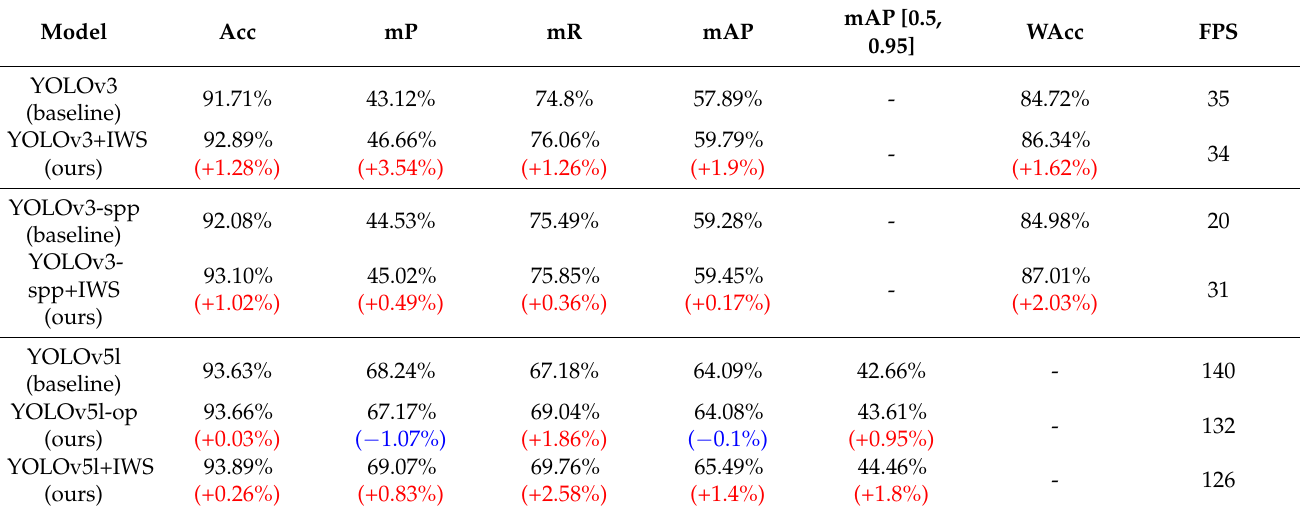
Table 8. Experimental results of the IGBT_DF_L dataset based on YOLO